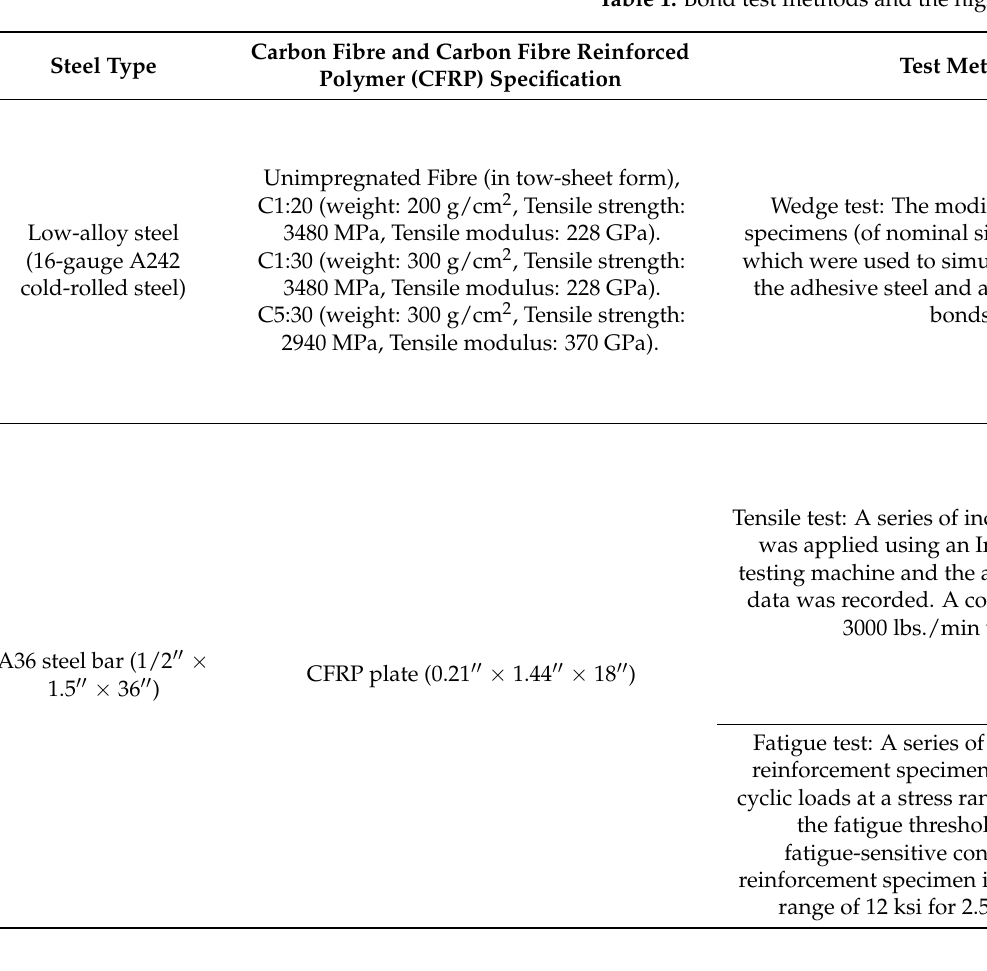
Table 1. Bond test methods and the highlights of the previous